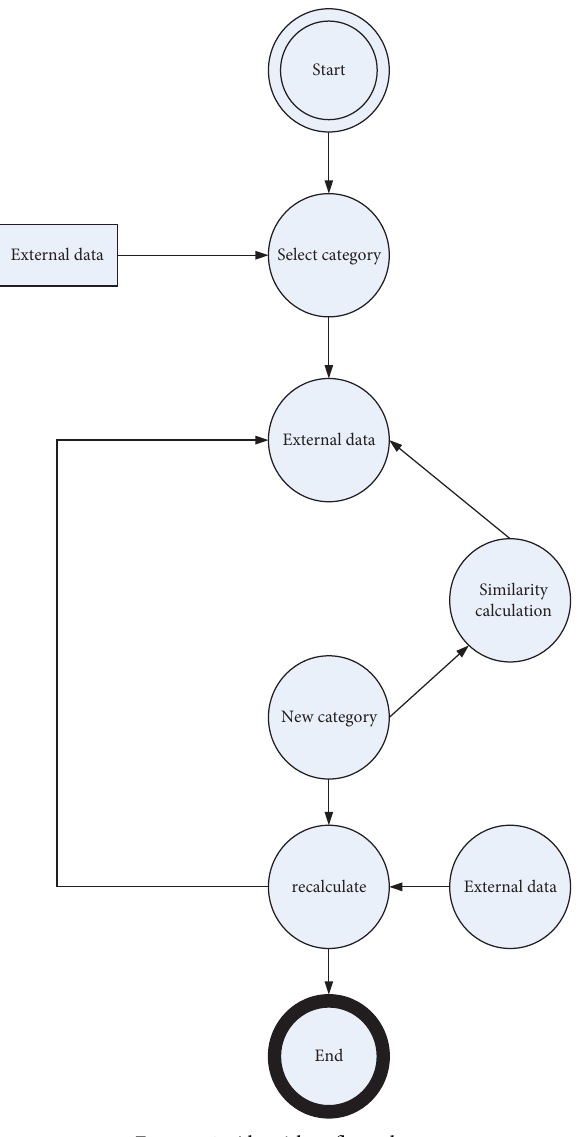
Figure 1: Algorithm fow